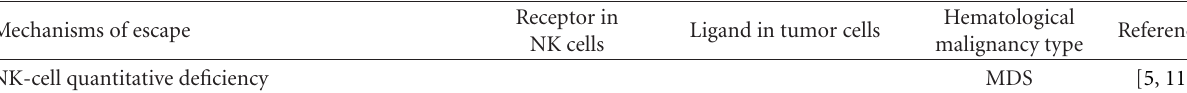
Table 1: Mechanisms of escape, receptor, and ligand involved and type of hematological